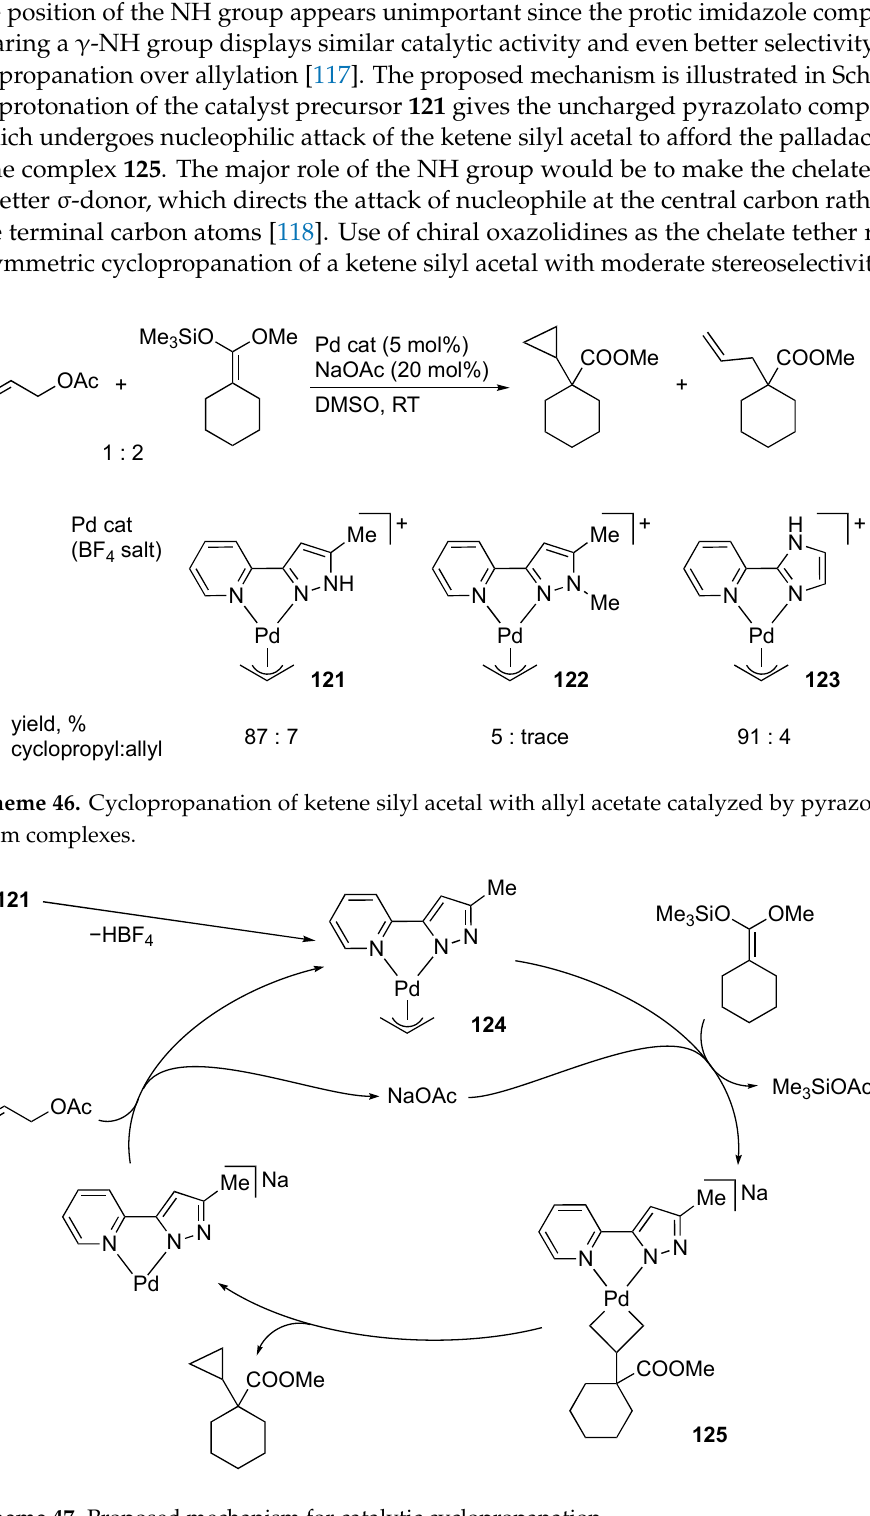
Scheme 47. Proposed mechanism for catalytic cyclopropanation.